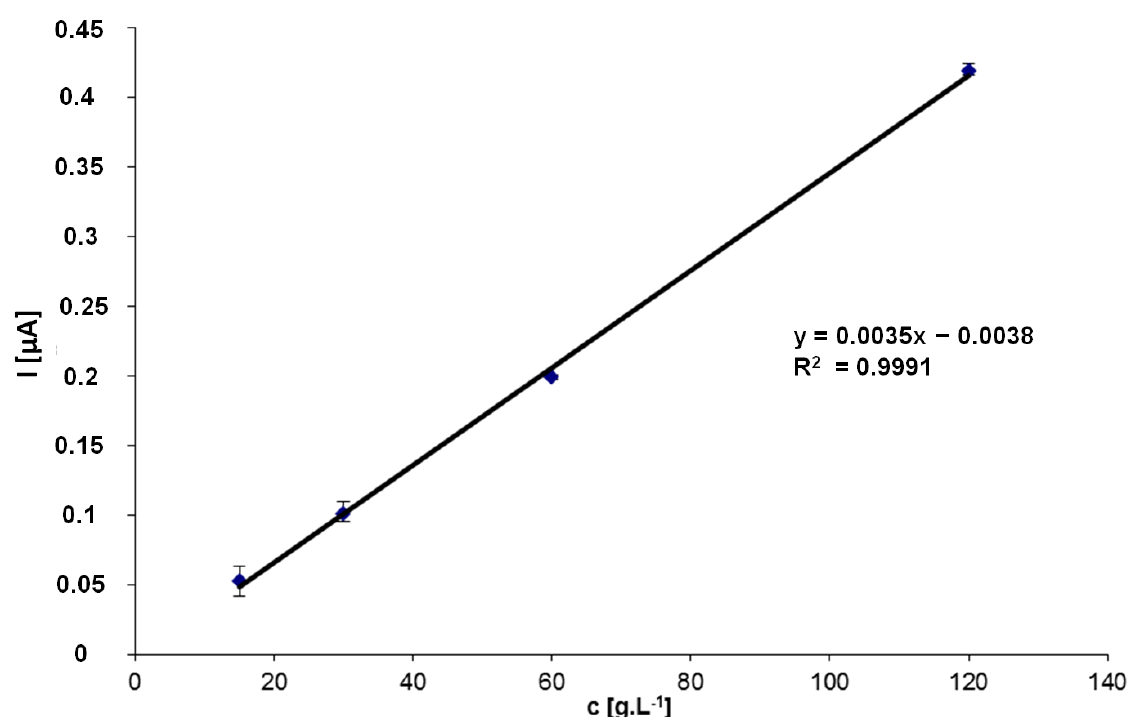
Figure 1. Biosensor (screen-printed carbon electrode (SPCE)/RhO 2 /ADH) response current to ethanol